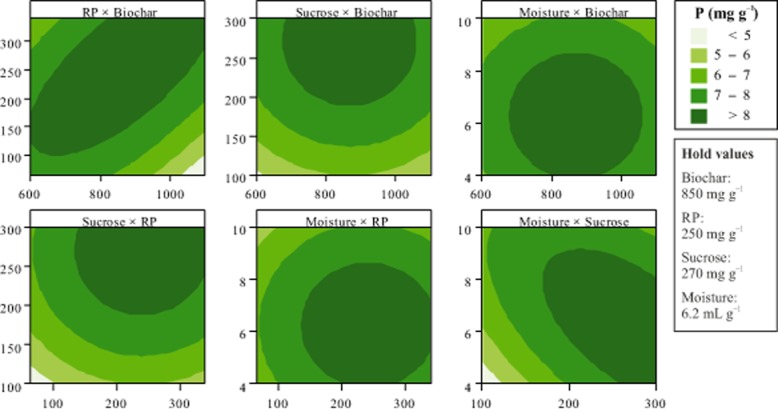
Levels of P solubilized by Aspergillus niger FS1 in a SSF in response to different combinations of biochar, RP, sucrose and moisture. The fermentations were performed for 7 days at 30°C using sugarcane bagasse as substrate. In each panel, the variables not presented were hold at the optimum value as indicated in the box.